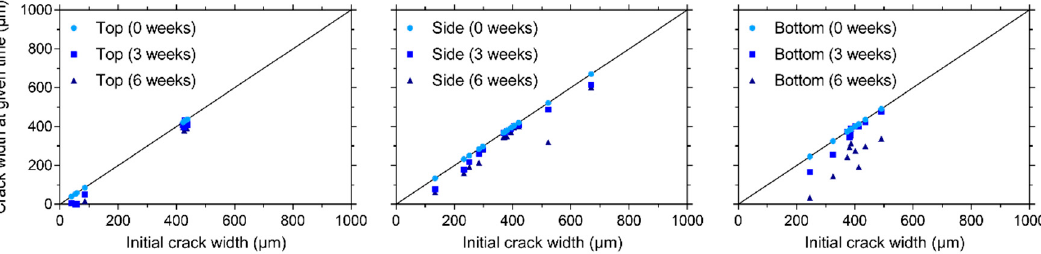
Figure 10. Evolution of the crack width under saturation on the top, side, and bottom surfaces.